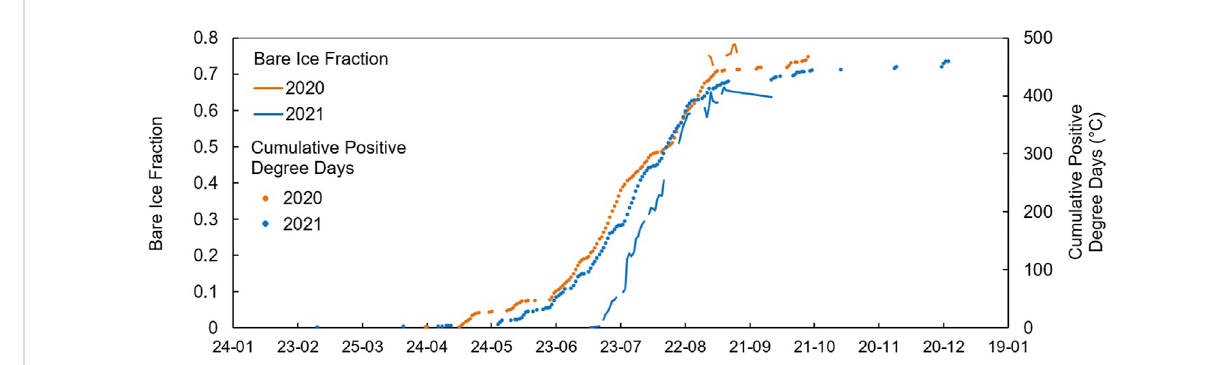
FIGURE 6 Fraction of Bare Ice versus Cumulative Positive Degree Days on QAS during 2020 and